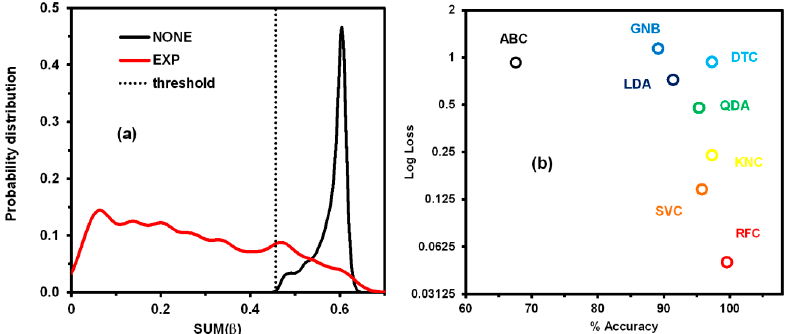
Figure 6. ( a ) Probability distribution of the sum of β j (SUM ( β )) for a simple binary discrimination model. ( b ) Comparison of the tested machine learning (ML) methods in terms of their log-loss and accuracy.